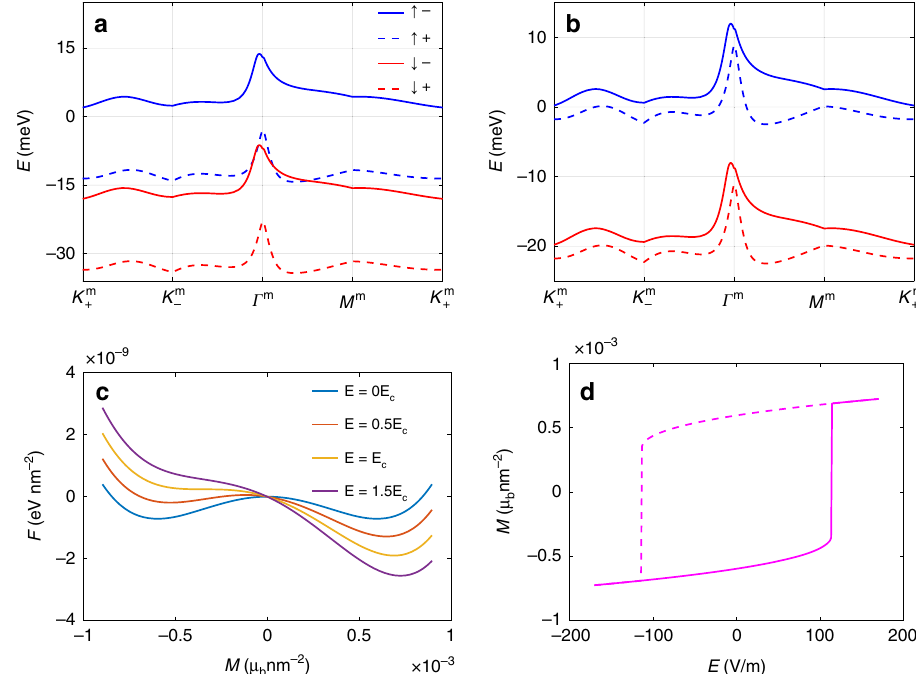
Fig. 4 Current induced magnetization switching. The interaction-renormalized bands at 3/4 fi lling for heterostrain ϵ ¼ 0 : 1 % are shown in a for fully- fi lled spin- and valley-polarized bands, and in b for spin-polarized but valley-unpolarized bands. c Free energy as a function of magnetization for several values of applied electric fi eld along the y direction. At the coercive electric fi eld E , one local minimum of the free energy collapses and only one minimum remains. c 113 d The magnetic hysteresis curve induced by the electric fi eld along the y direction. The coercive fi eld is estimated to be around E c ¼